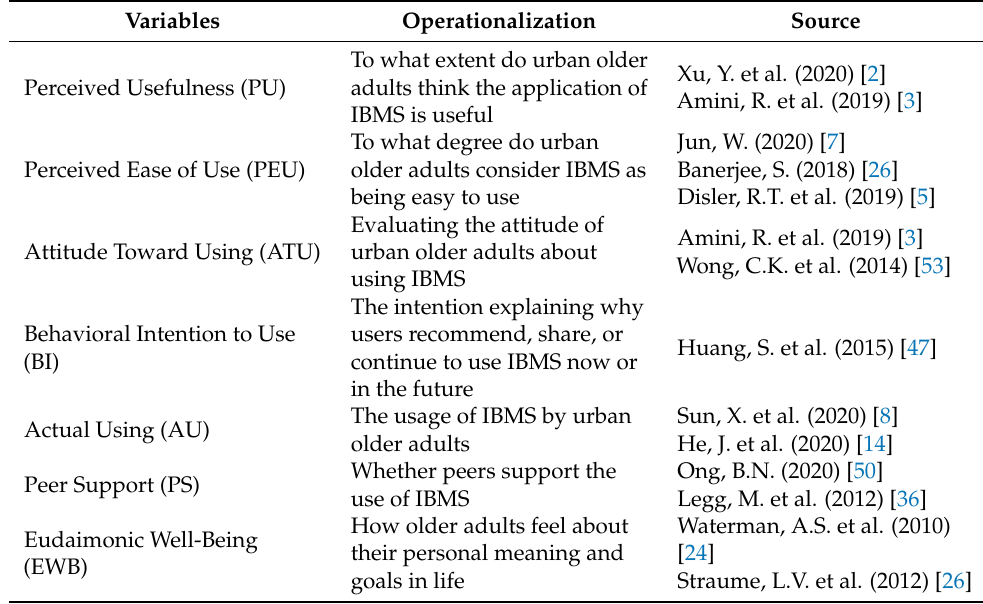
Table 1. The operationalization and sources of the questionnaire